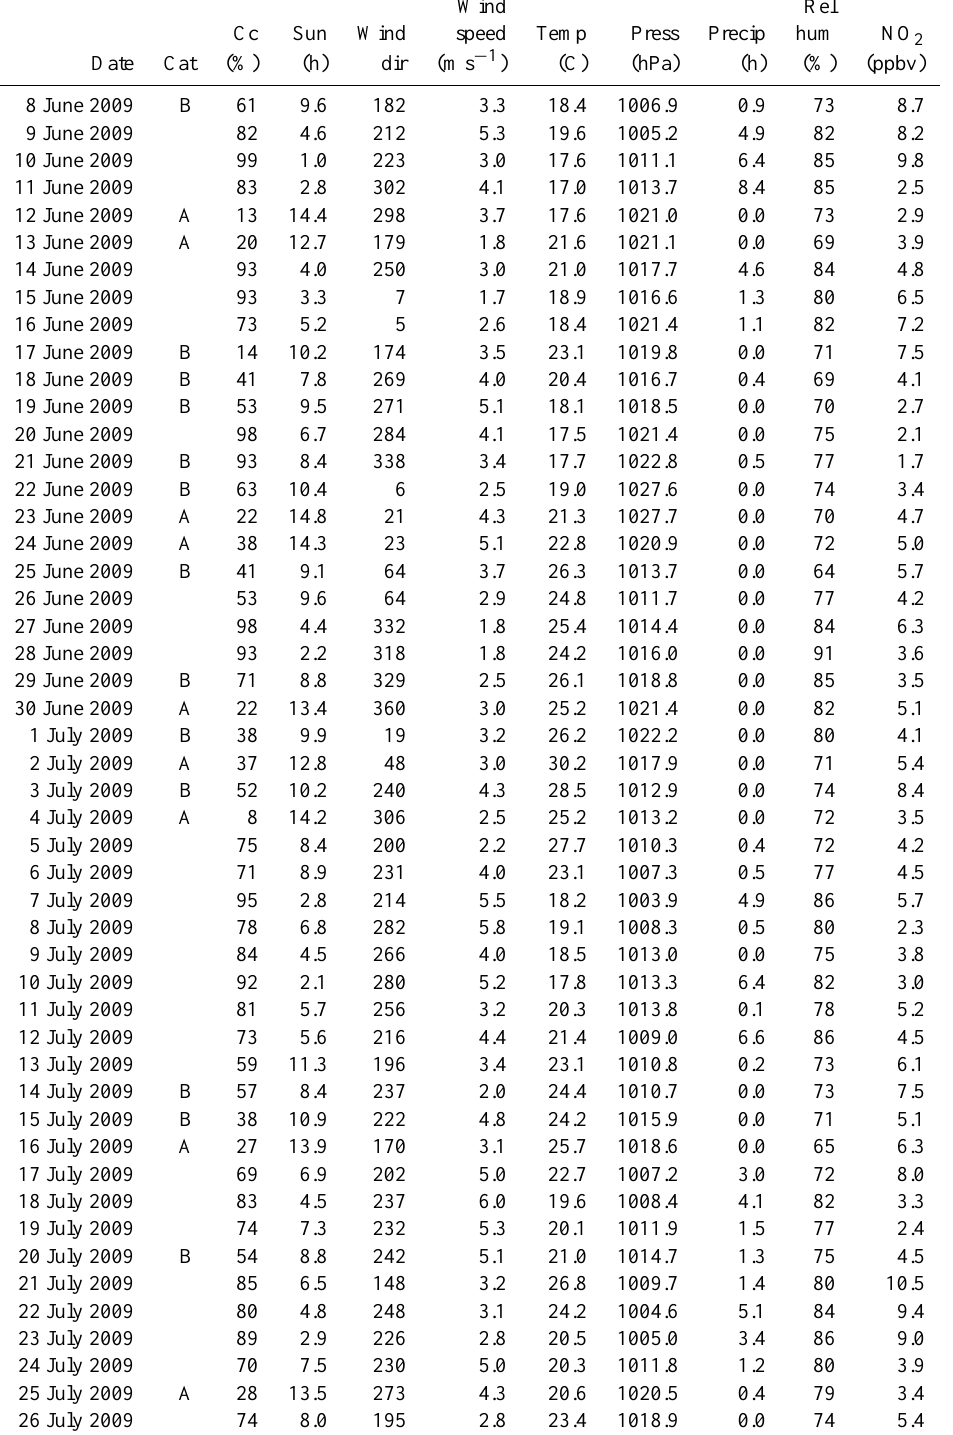
Table B1. Average meteorological values during CINDI, see description in Appendix